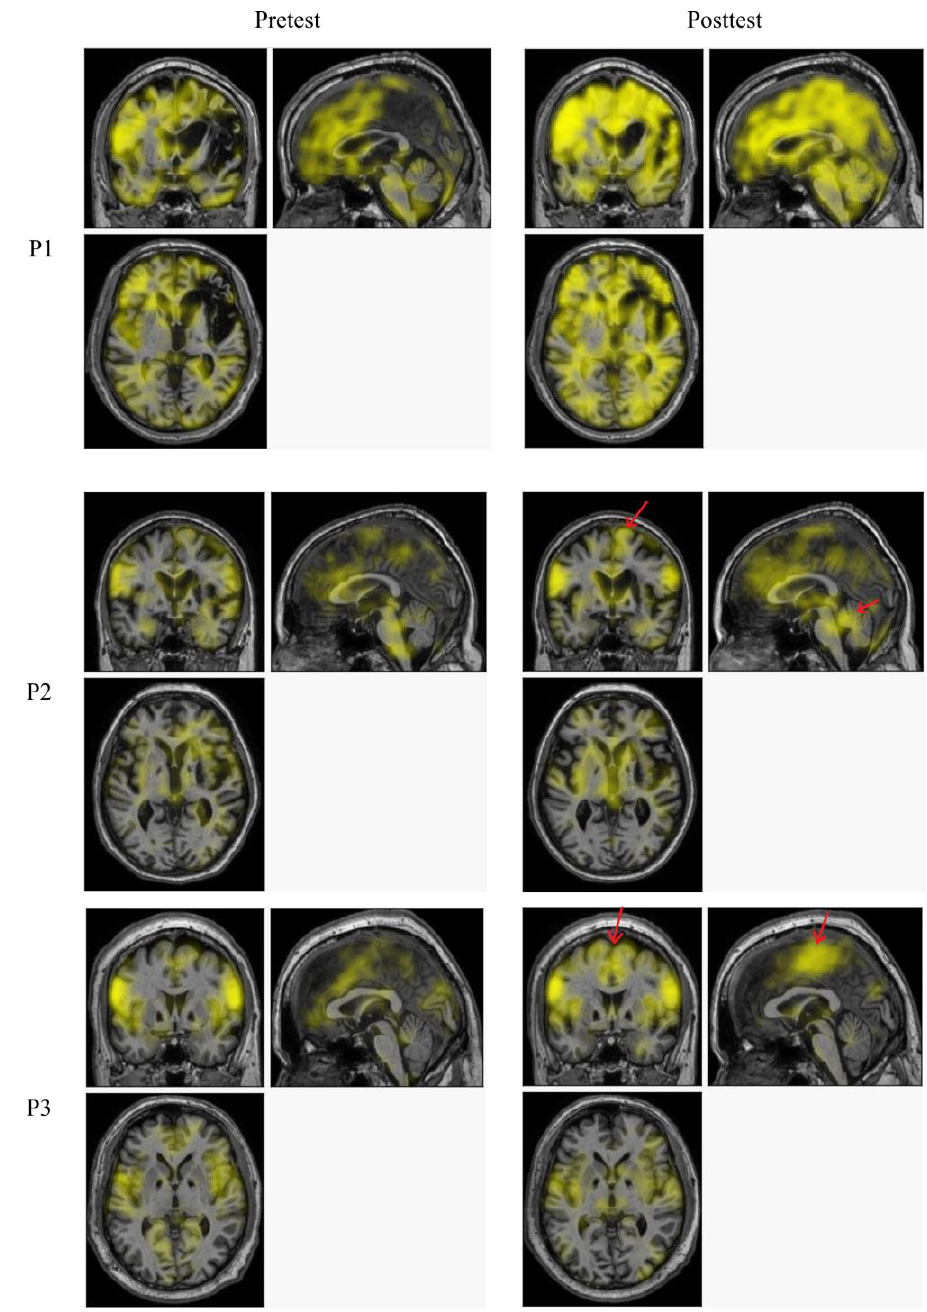
Figure 4. Positive correlation maps with the seed in the left motor area at pretest (left column) and post-test (right column). Each line shows maps for a patient, from top to bottom: P1, P2 and P3. Brighter colors indicate higher correlation values and/or a larger number of correlated voxels. In particular, red arrows for P2 and P3 indicate increases in motor-related areas.